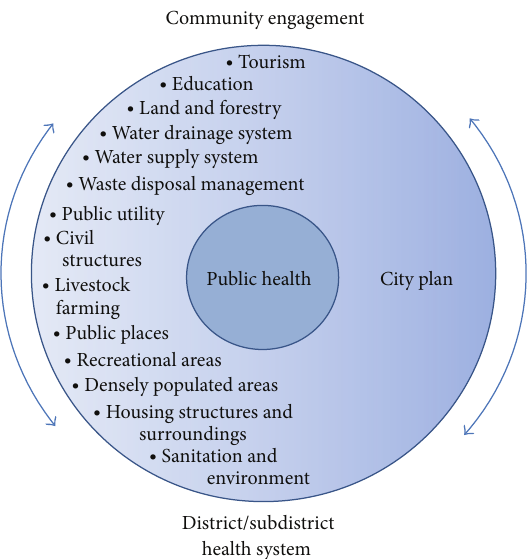
Figure 1: Determined missions on public health and other related firms for city development. In conjunction with district/subdistrict health system and city development, such actively engaged local governments commit to providing service delivery for public health and other human well-being to local people and community by making use of public service